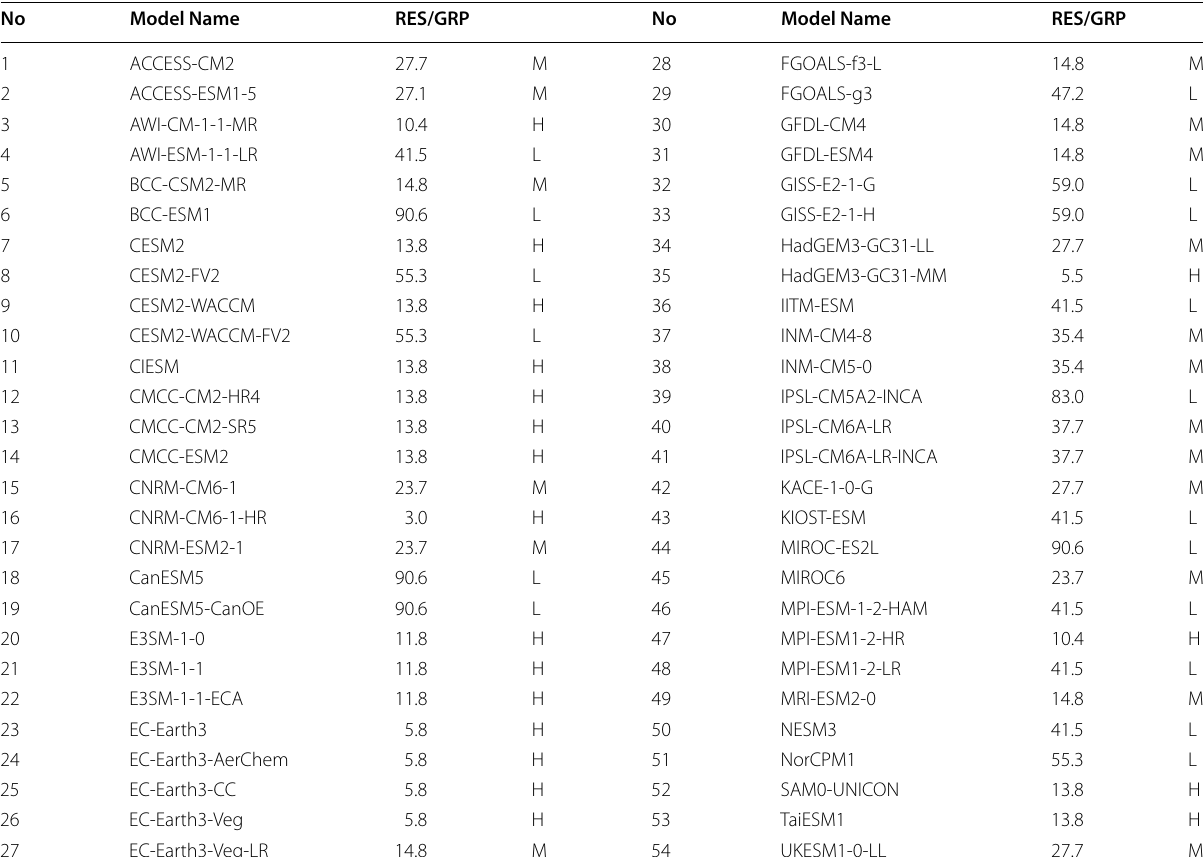
Table 1 A list of 54 CMIP6 models and their respective spatial resolutions